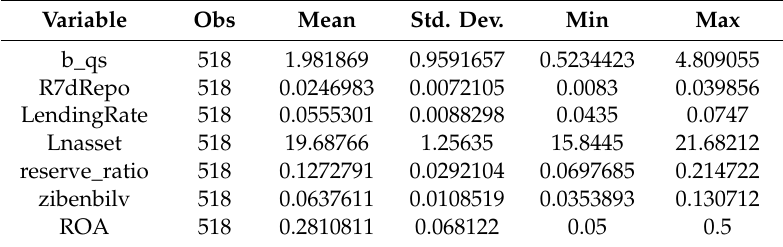
Table 2. The descriptive statistics of